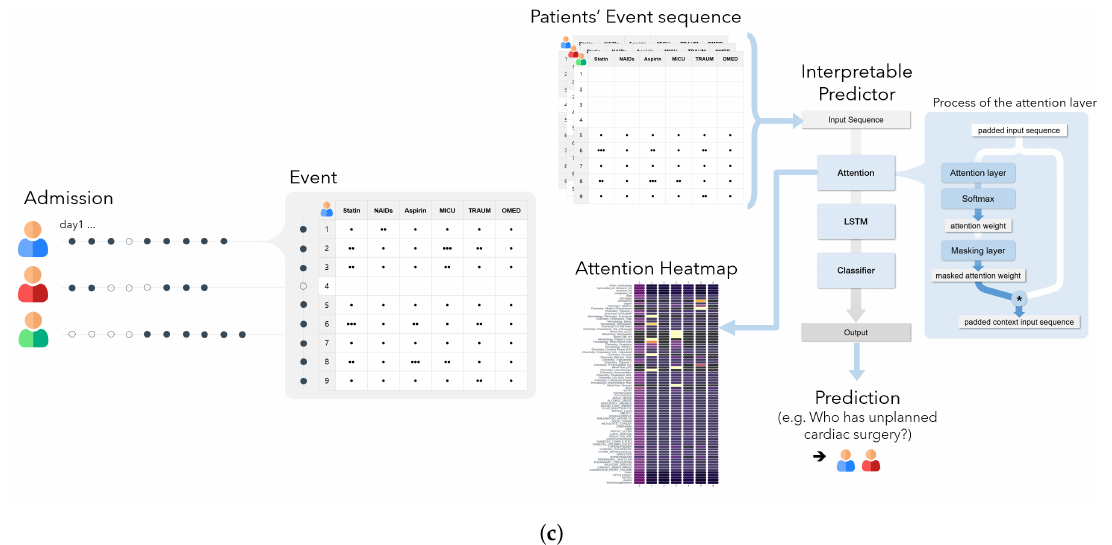
Figure 2. Architecture of the long short-term memory (LSTM) attention model. ( a ) The overall structure of the LSTM attention model and ( b ) the detailed process of the attention layer. Further, ( c ) shows the entire modeling process, including the data input and